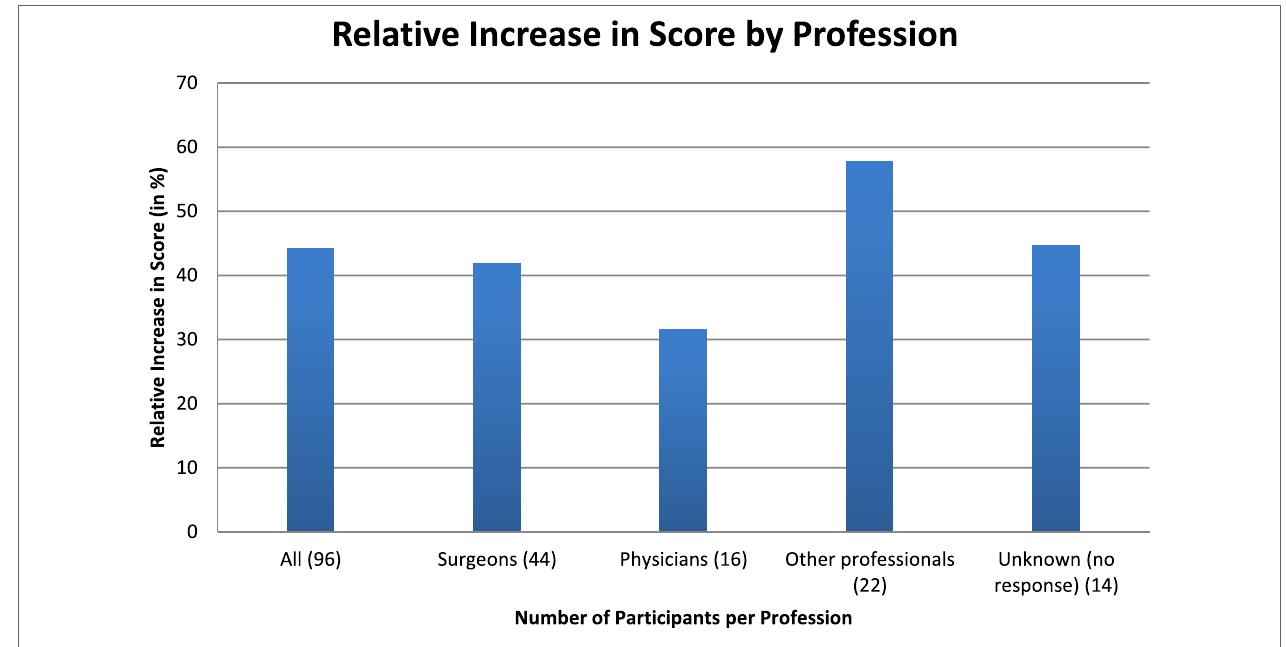
FigUre 2 | Relative increase in scores from pre-course to post-course questionnaire by profession.